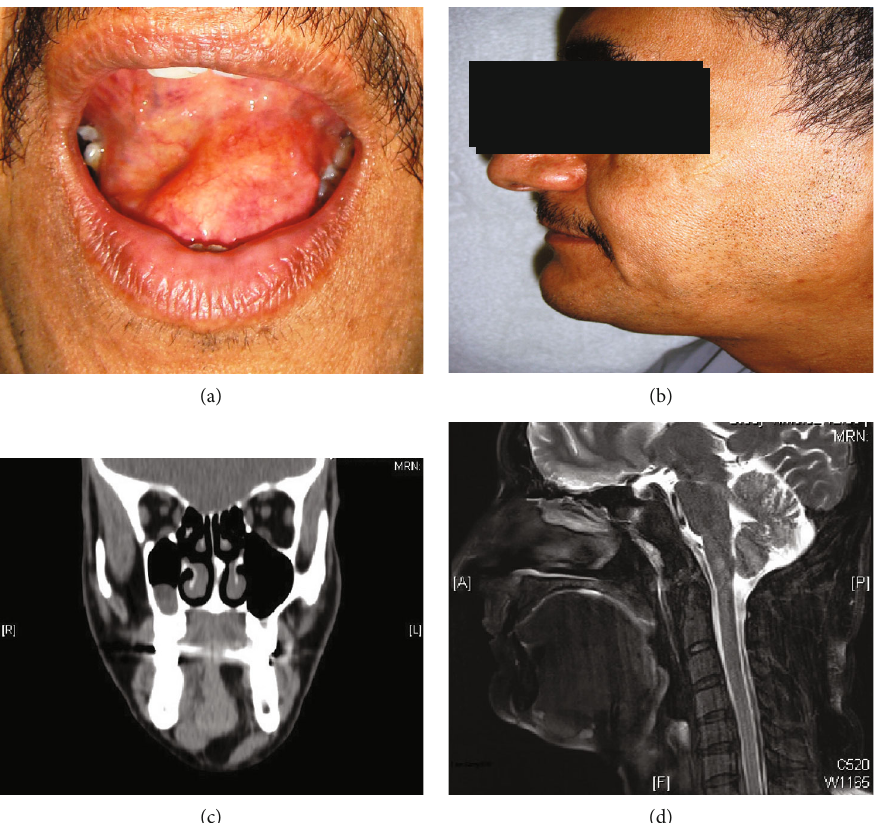
Figure 1: (a) Intraoral soft tissue mass in the fl oor of the mouth from the left ventral tongue surface extending beyond the midline to the right side. (b) Mild submental swelling as a result of an intraoral mass herniation beyond the mylohyoid muscle. (c) Coronal CT section at the level of the fi rst molar in soft tissue window showing a markedly low density and clearly de fi ned margin irregular mass within the left genioglossus muscle extending from ventral tongue to skin overlying the mylohyoid muscle. The density is homogenous and similar to adjacent subcutaneous fat. (d) Midsagittal MRI section in fat suppression showing the hypointense density